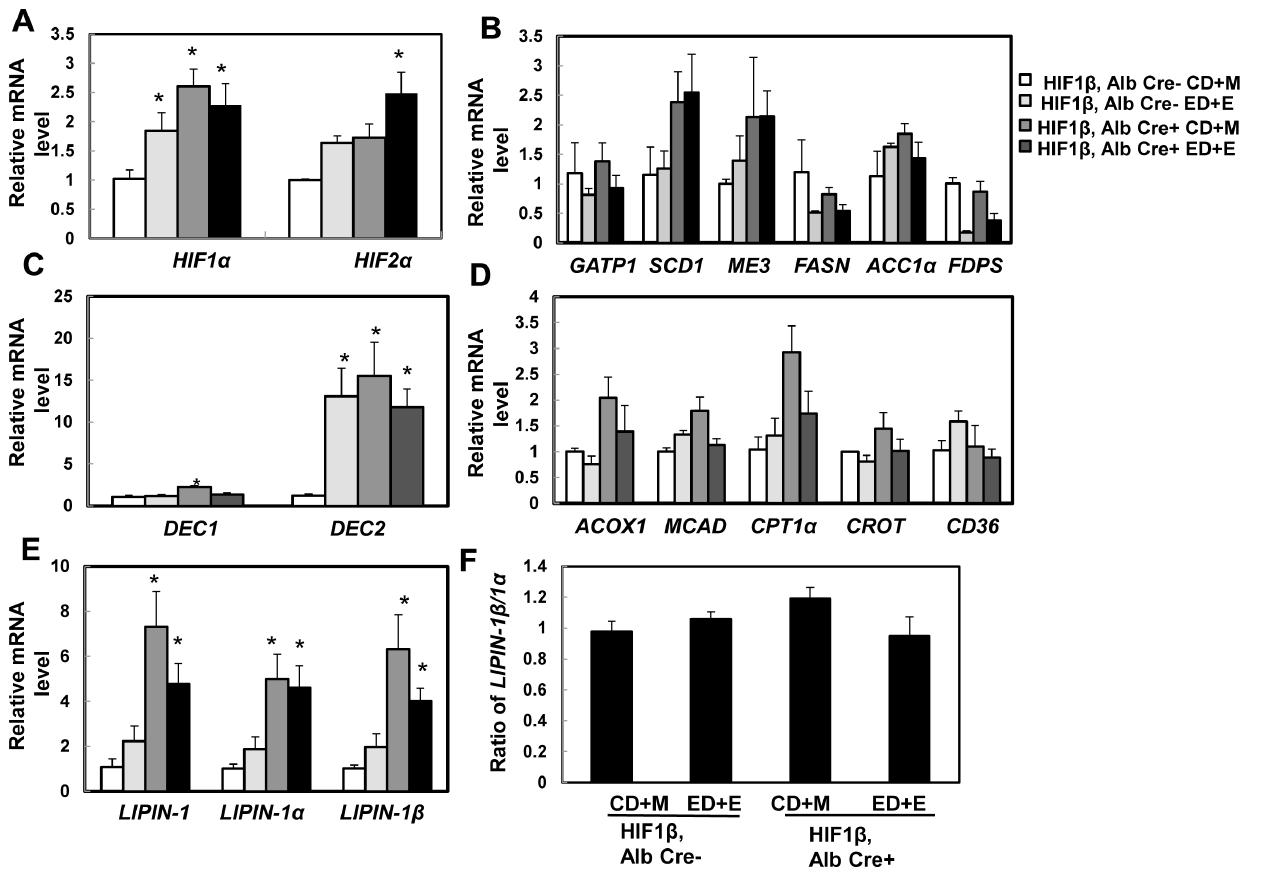
Fig. 5. Expression of lipid metabolism genes after Gao-binge treatment in wild type and hepatocyte-specific HIF-1 b knockout mice. Age matched male wild type and hepatocyte-specific HIF-1 b knockout mice were subjected to Gao-binge treatment. Hepatic mRNA was isolated, and real-time RT-PCR was performed as described in the Materials and Methods to quantify expression of HIF (A), lipogenesis genes (B), DEC1 and DEC2 (C), fatty acid oxidation (D), and LIPIN-1 (E). The ratio of LINPIN-1 b /LINPIN-1 a was calculated based on (E) and is shown in (F). Data are presented as means ¡ SE (n 5 3–5). CD + M: Control diet + maltose; ED + E: Ethanol diet + ethanol binge. * p , 0.05, vs HIF-1 b CD + M group. One way ANOVA with Scheffe´’s post hoc test.